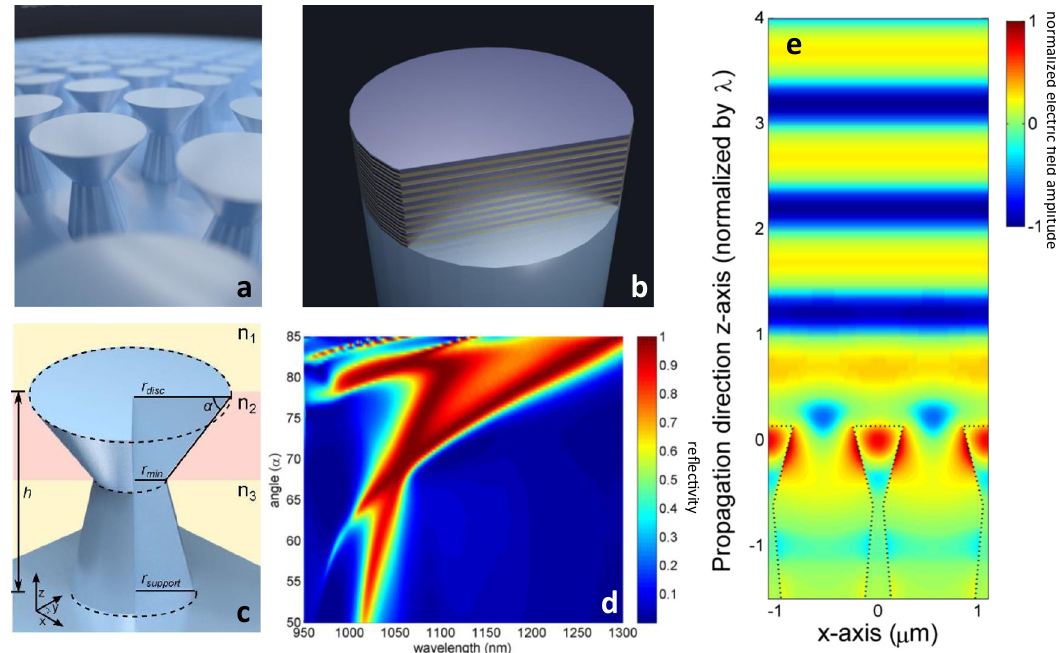
Fig. 1 Design and simulation of a mirror in single-crystal diamond. a Graphical depiction of a diamond mirror with the “ golf tee ” -shaped columns arranged in a hexagonal lattice. b Typical multilayered optical coating deposited onto a substrate. c Schematic of the “ golf tee ” columns that comprise the diamond mirror, with all relevant dimensions labeled: angle α , radii r disc , r min , r support , and total height h . The shaded yellow region labeled n 1 is of lowest refractive index (air), the red region n 2 contains the top portion of the column that features optical resonances and is of highest refractive index, while the yellow region n 3 is of lower refractive index and supports the top portion of the column. d Diamond mirror re fl ection spectrum at normal incidence for varying design angles α , with r disc = 250 nm, r min = 50 nm, r support = 250 nm, pitch 1.1 μ m, and h = 3 μ m. Colors indicate re fl ectivity. e Standing-wave pattern illustrating the re fl ected wavefront from a diamond mirror at a wavelength of 1064 nm. Mode is con fi ned in the top portion of the columns due to lattice resonance. Colors indicate the electric fi eld amplitude. Photo credit for panels ( a ) and ( b ): P. Latawiec,